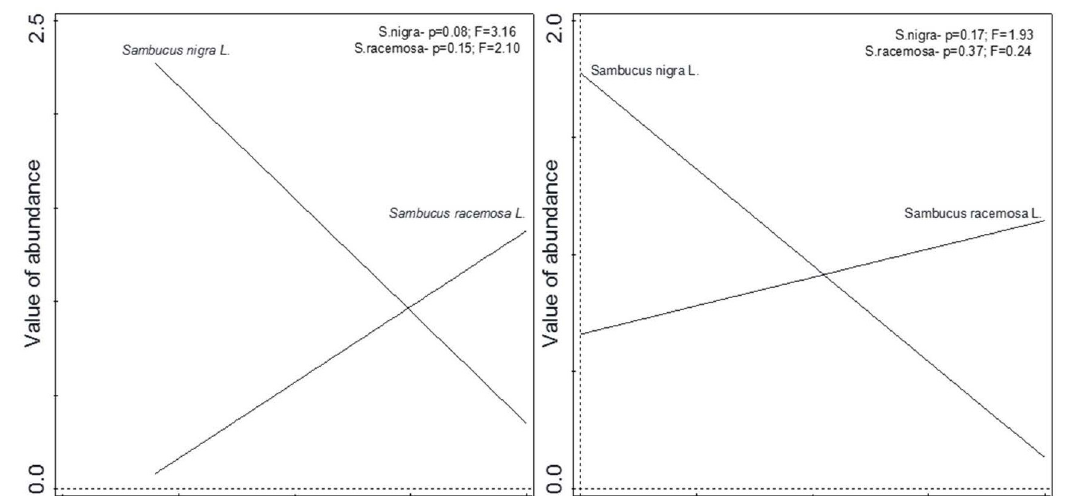
racemosa and no clear association with dendrometric stand parameters (Figure 10). Sorbus aucuparia, Aegopodium podagraria, Polygonatum odoratum, Maianthemum bifolium, Acer platanoides species were characteristic for communities with Sambucus nigra and occurred in more fertile forest sites.